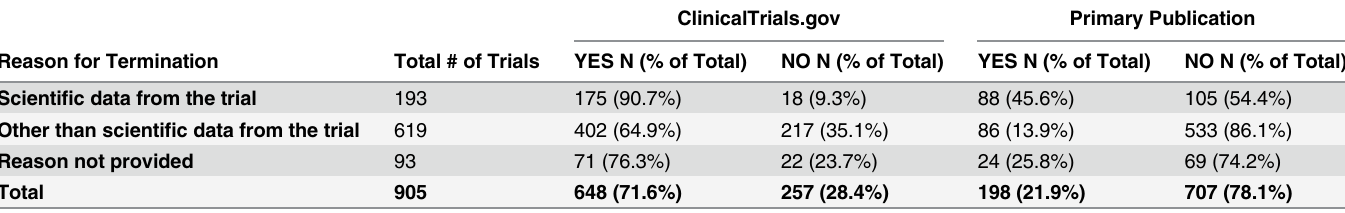
Table 2. Termination categories and whether results for a primary outcome measure were (a) reported on ClinicalTrials.gov or (b) published in a biomedical journal (as of December